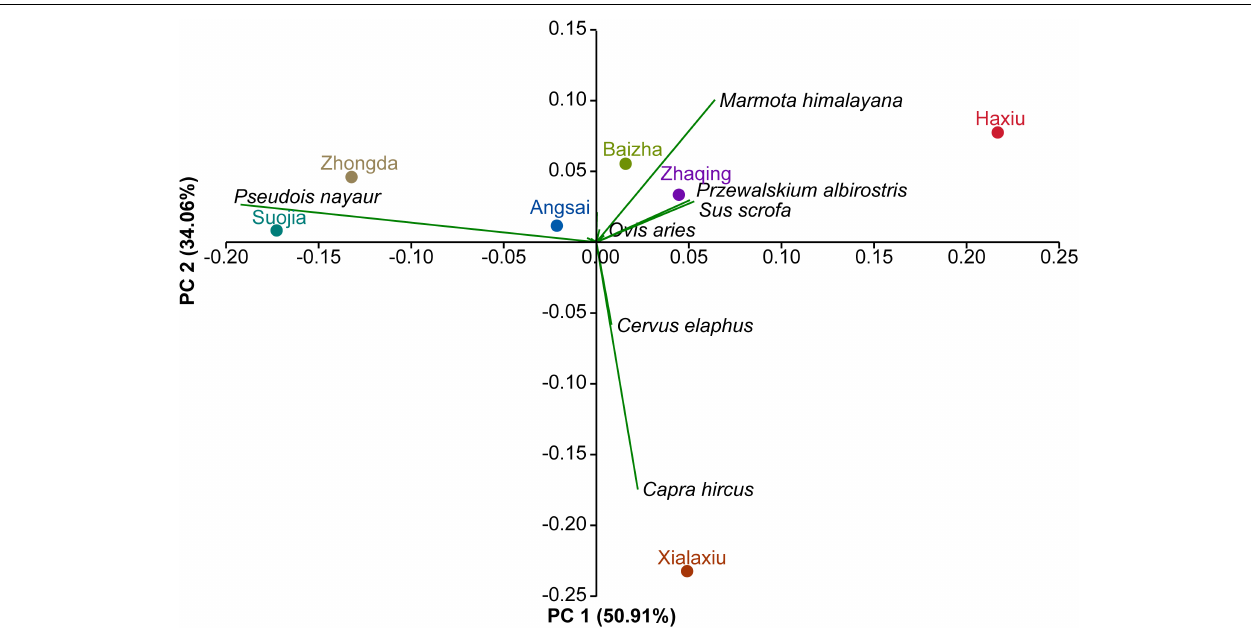
FIGURE 3 | Principal component analysis of snow leopard prey composition at seven sampling sites. Site positions are shown in relation to the relative read abundance of the select prey species that contributed the most to areal dietary differences.